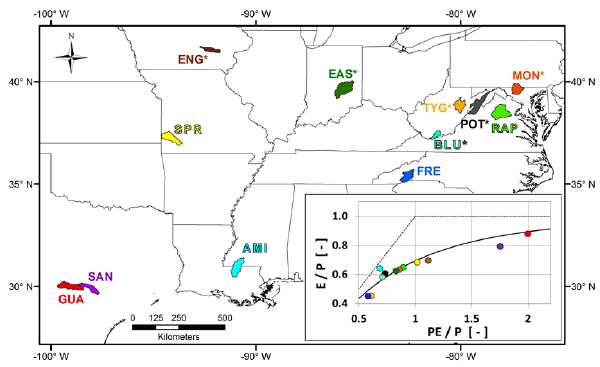
Figure 1 Fig. 1. Study sites location. Snow catchments are indicated with an ∗ . Inset: Evaporation Index ( E/P) vs. Aridity Index ( E p /P) , continuous black curve corresponds to Eq.